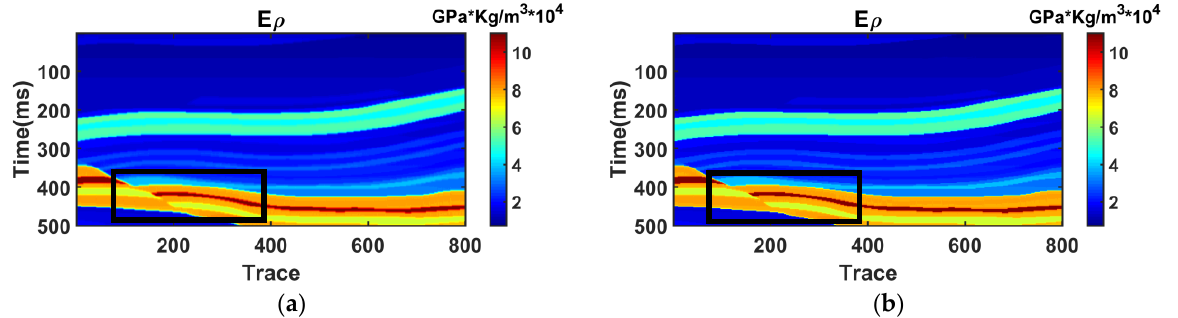
Figure 4. E ρ inversion results based on ( a ) traditional method and ( b ) reweighted Lp method.